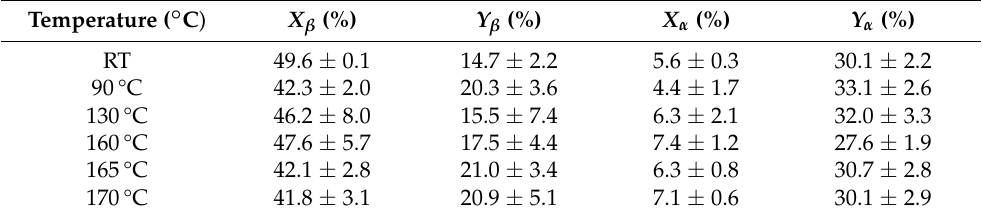
Table 4. Share of crystalline X and amorphous Y α - and β -phase (n RT = 10, n 90 to 170°C =